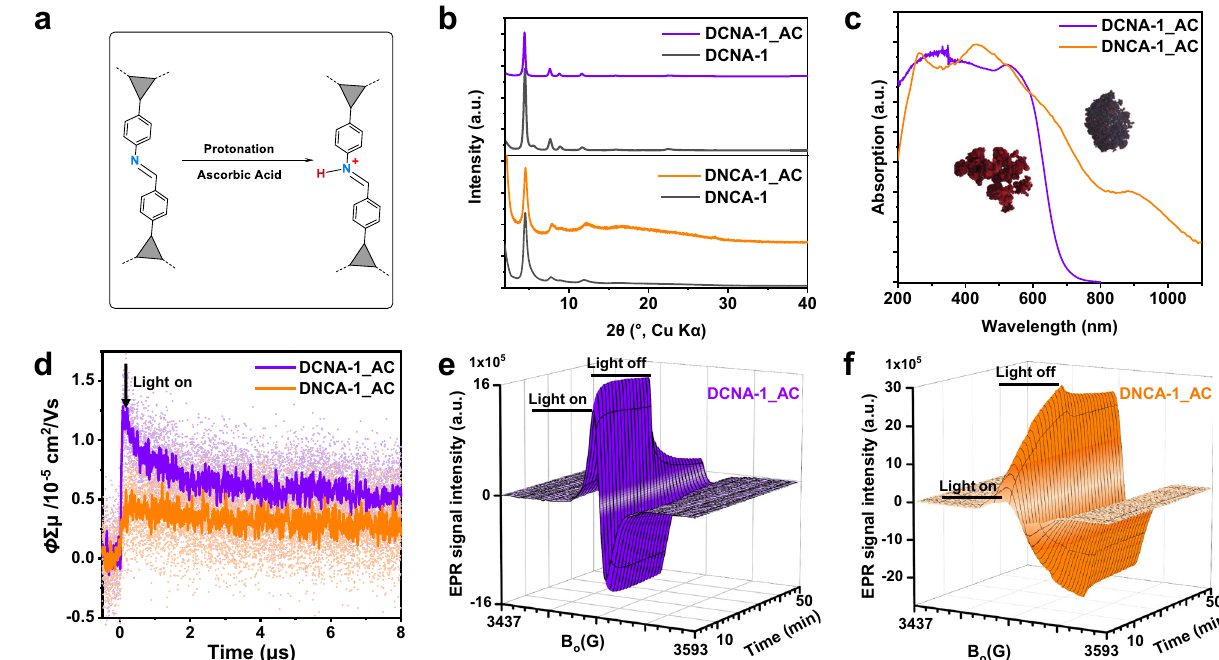
Fig. 3|PhotophysicalpropertiesoftheprotonatedisomericCOFs.a Schemeof the protonation of the imine linkage. b PXRD patterns, ( c ) UV-Vis DRS spectra, ( d ) FP-TRMC transients of DCNA-1_AC and DNCA-1_AC. EPR CB electrons spectra of